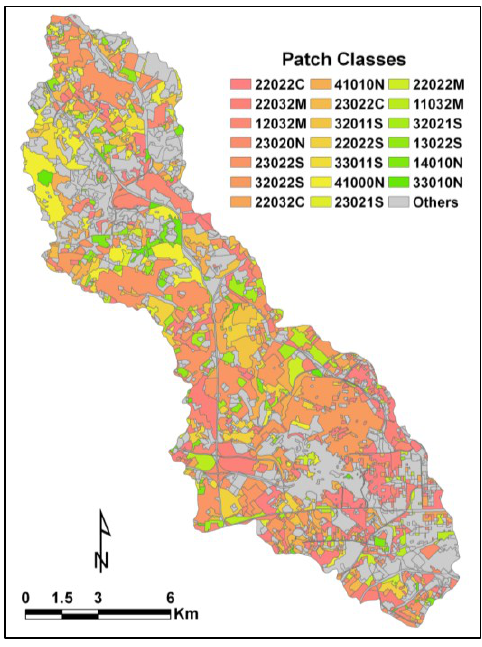
Figure 6. HERCULES patch classification for the Gwynns Falls watershed in 2004. The legend lists the first 20 dominant classes, which accounted for 48.8% of all the